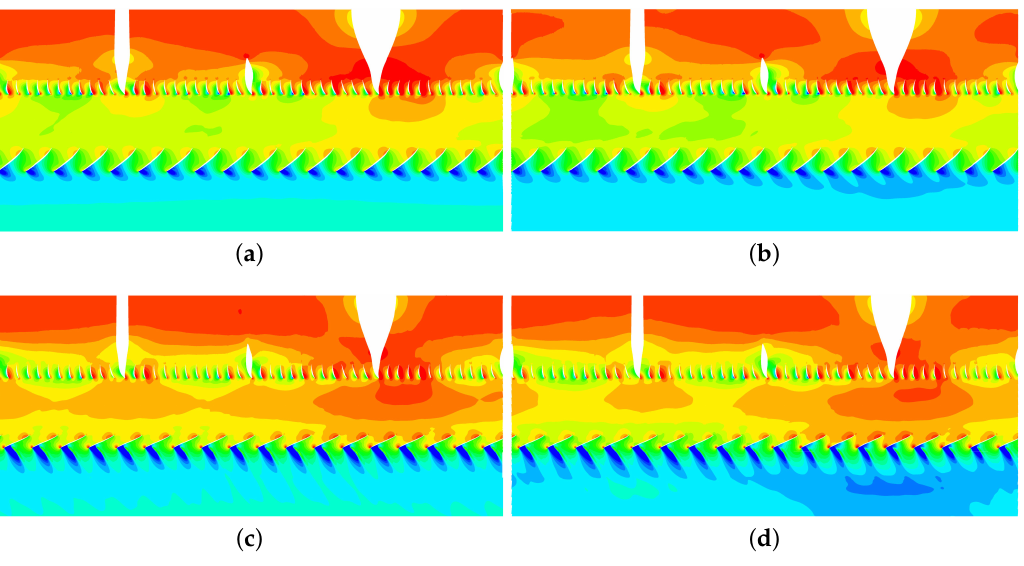
Figure 10. Static pressure contours at different channel heights for the axisymmetric (left) and the asymmetric (right) air-inlet geometries. ( a ) 50% of channel height, axisymmetric air inlet; ( b ) 50% of channel height, asymmetric air inlet; ( c ) 95% of channel height, axisymmetric air inlet; ( d ) 95% of channel height, asymmetric air inlet.